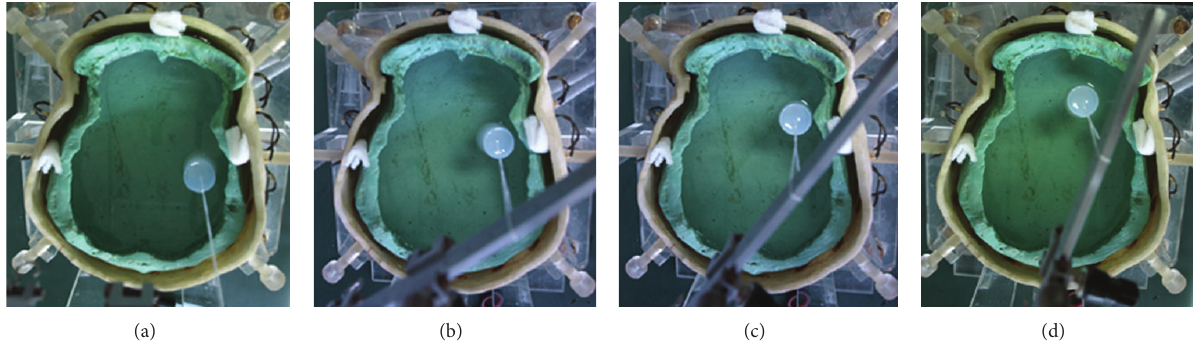
Figure 12: Four locations of the agar cylinder at the anterior and left part of the phantom.